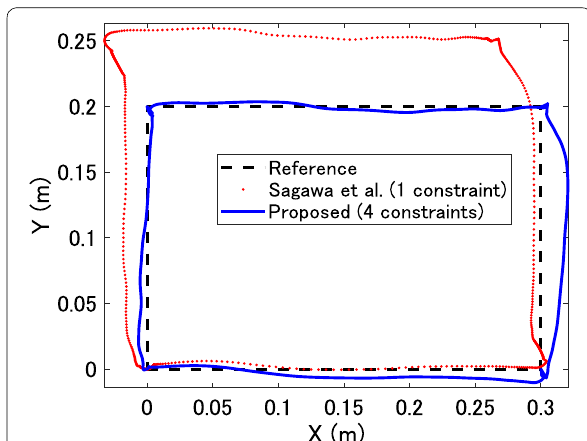
Fig. 7 Two dimensional projection of the estimated trajectories using real IMU